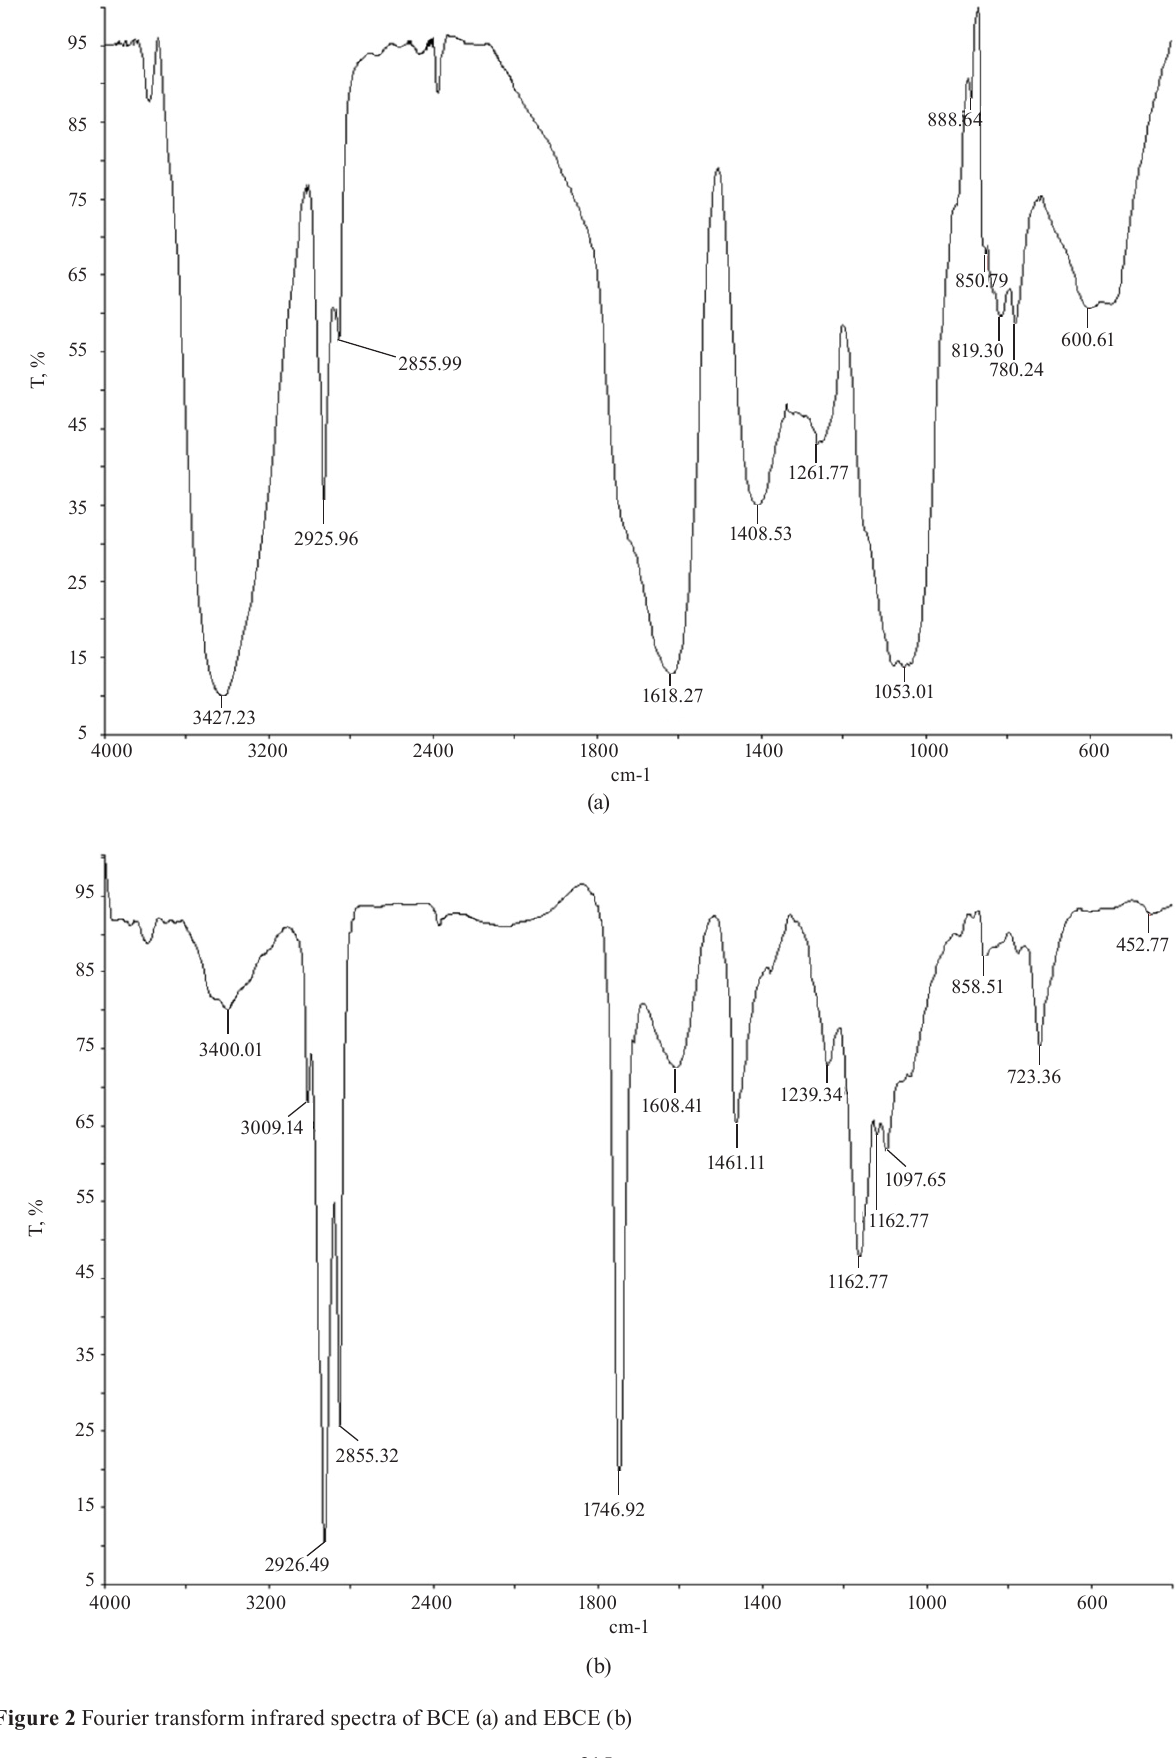
Figure 2 Fourier transform infrared spectra of BCE (a) and EBCE